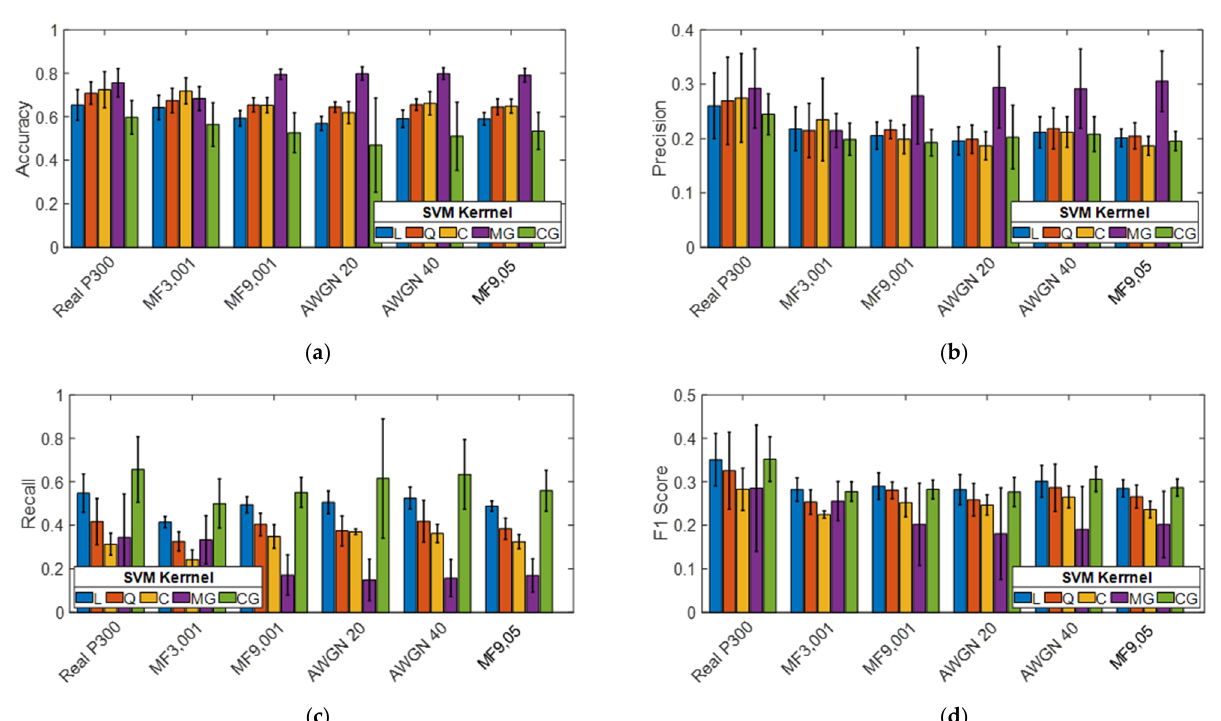
Figure 2. Test of the SVM models using the real P300 dataset (real P300) vs. hacked P300 datasets. Performance metrics are ( a ) accuracy, ( b ) precision, ( c ) recall, and ( d ) F1 score. Data are represented as averages and standard deviations over the five subjects.